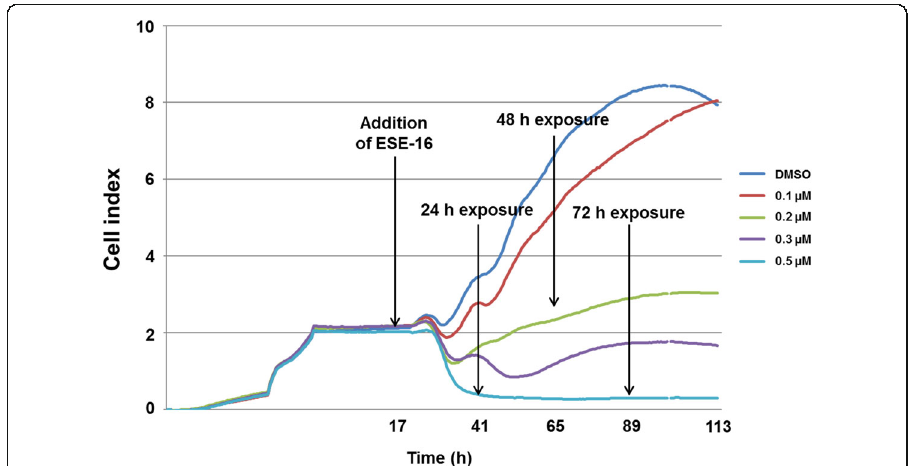
Fig. 2 Real-time cell monitoring illustrating an analysis profile of the HeLa cells in response to ESE-16 exposure.